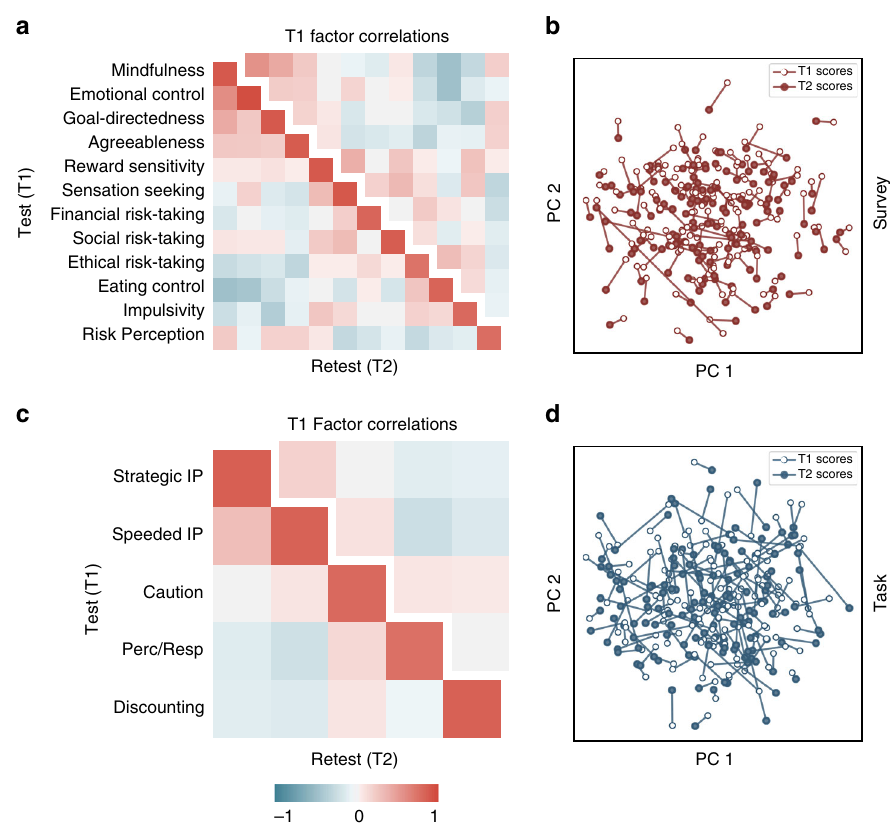
Fig. 5 Retest reliability and correlations of factor scores. The EFA model derived from the full dataset ( n = 522) was applied to a subsample of participants who repeated the entire battery within 4 months ( n = 150) to compute factor scores (T2 scores). These factor scores were then correlated with factors scores derived from the same participants during their original testing (T1 scores). The lower triangle and diagonal of the heatmaps re fl ect these correlations and are displayed for both surveys ( a ) and tasks ( c ). The diagonal shows high factor score reliability within-individual across time. The separated upper triangle depicts the factor correlation structure at T1. To visualize the relative stability of individual factor scores compared to group variability, the factor scores were projected into a 2-dimensional space de fi ned using principal components analysis ( b, d ). T1 scores are depicted using an empty circle and T2 scores are depicted using a fi lled circle, with each individual corresponding to one